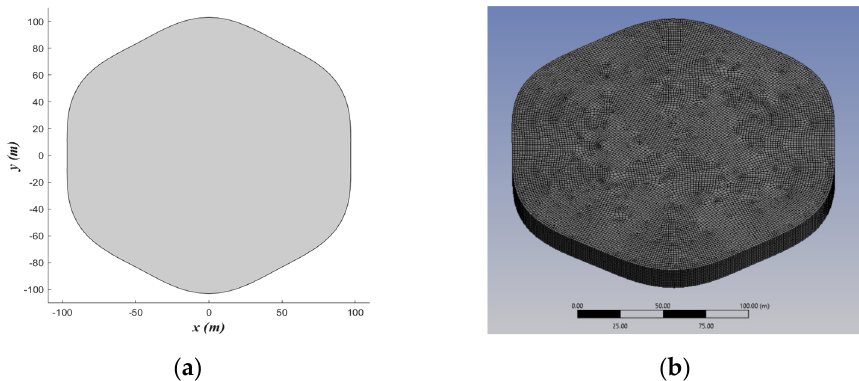
Figure 2. Hexagonal platform for verification study: ( a ) plan view; ( b ) 3D mesh model (AQWA).